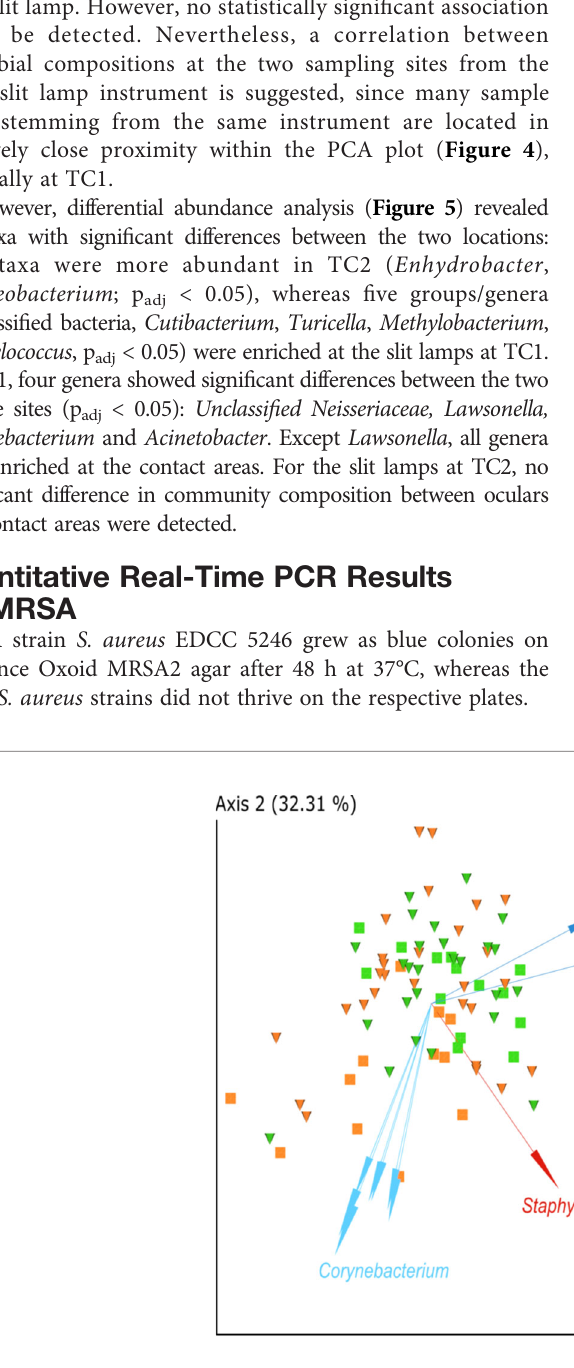
FIGURE 3 | PCA biplots of centred-log-ratio (clr)-transformed data for Location and Type, based on robust Aitchinson distances. Arrows indicate important log- ratios between features that strongly in fl uenced the principal component axis. Squares = TC1, cones = TC2, orange = ocular samples and green = contact area samples; TC, Tertiary